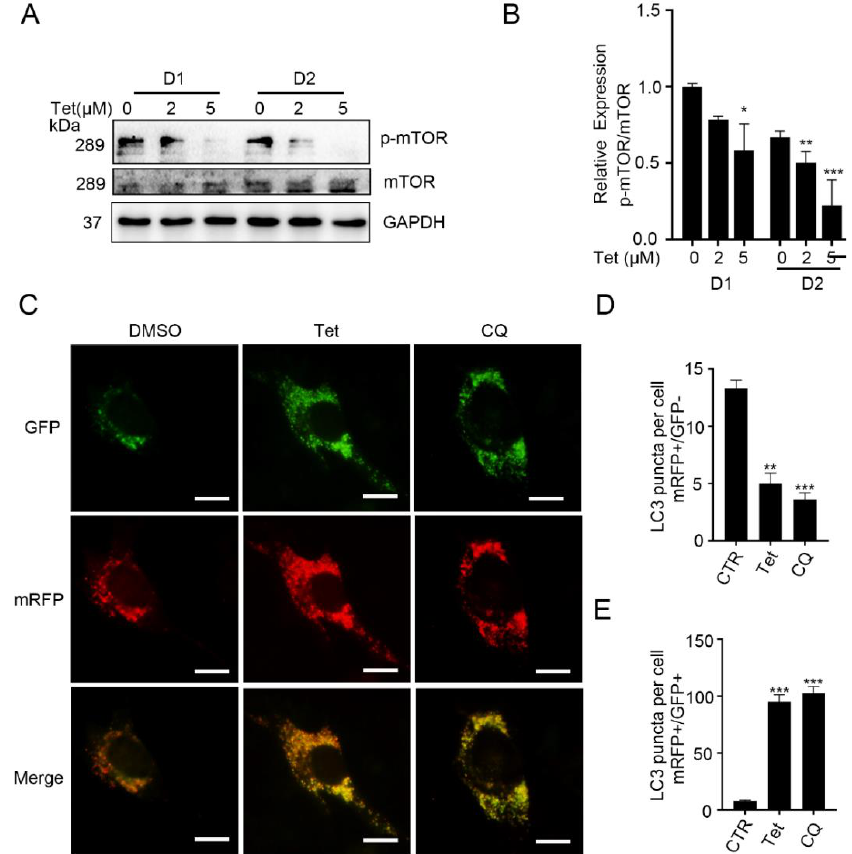
Figure 4. Tetrandrine activates the early stage and blocks the late stage of differentiation-induced autophagy. ( A ): Representative Western blots showing p-mTOR and mTOR levels in C2C12 myoblasts after 1 or 2 d of differentiation in the presence or absence of tetrandrine. ( B ): The expression ratios of p-mTOR/mTOR in A were quantified using Image J. n = 3, * p < 0.05, ** p < 0.01 and *** p < 0.001. ( C ): Fluorescent images of ad-mRFP-GFP-LC3-transfected C2C12 myoblasts after 1 d of differentiation in the presence of tetrandrine (2 µ M) or CQ (10 µ M). ( D , E ): The numbers of degraded autophagosomes